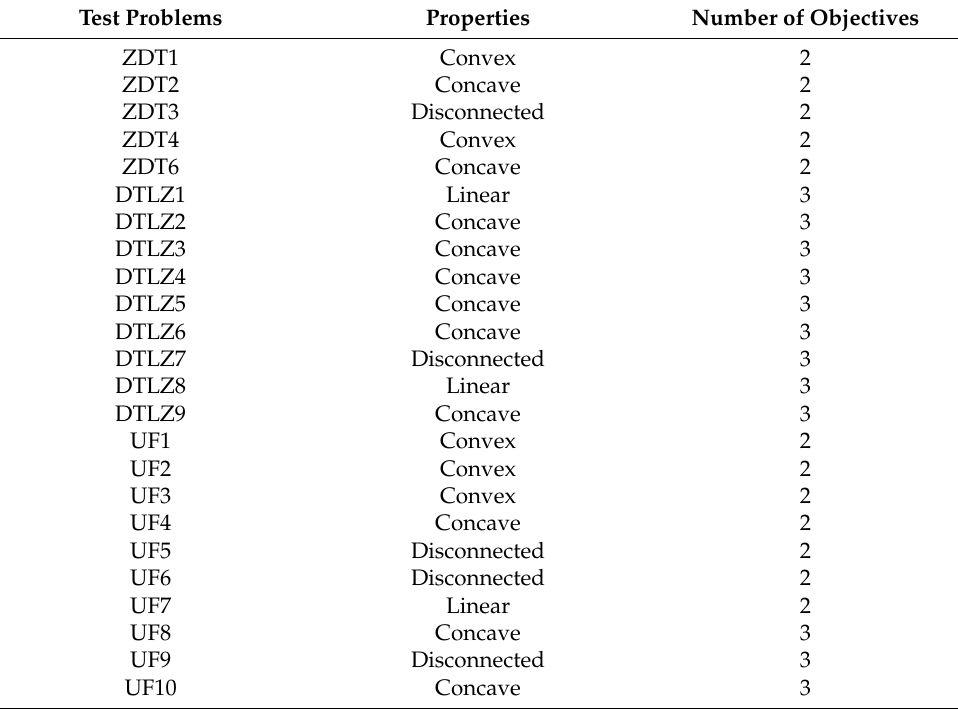
Table 1. Characteristics of benchmark test